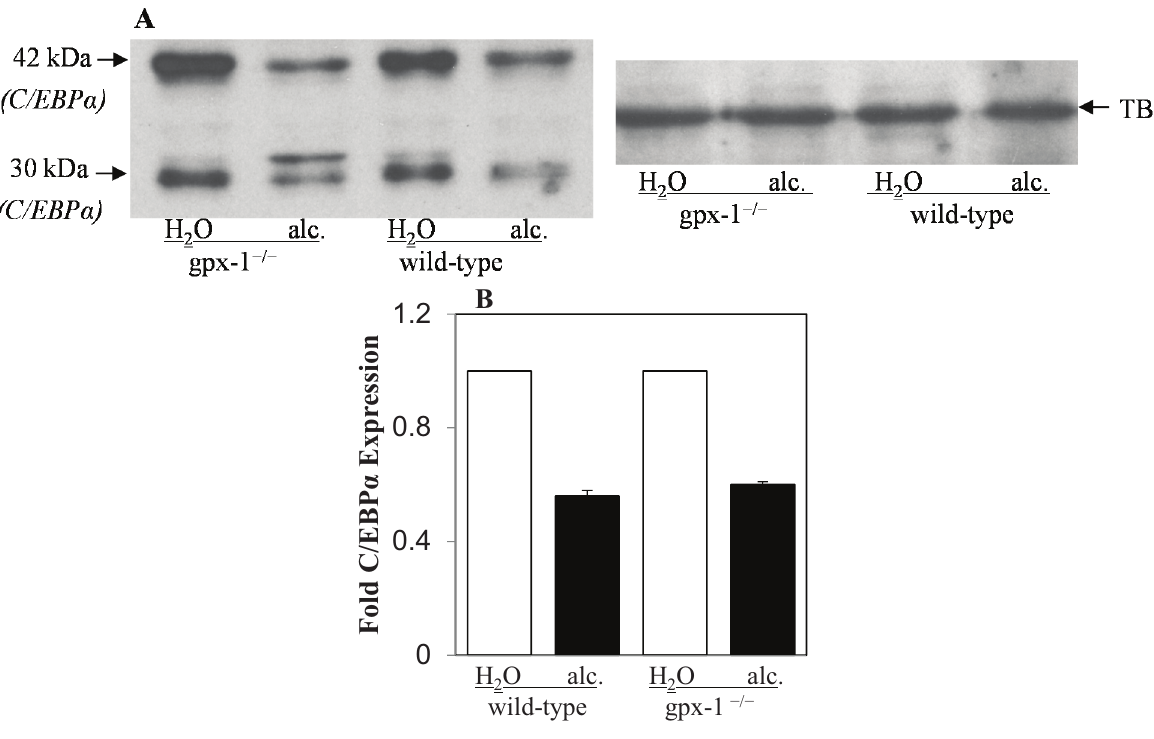
Figure 4. Liver C/EBP(cid:3) protein expression. ( A) Nuclear cell lysates isolated from the livers of H 2 O or ethanol (alc.)-fed wild-type and gpx-1 (cid:2)/(cid:2) transgenic mice were employed to detect C/EBP(cid:3) protein expression by western blotting. An anti-TATA-binding protein (TBP) antibody was used to demonstrate equal nuclear protein loading. ( B ) C/EBP(cid:3) protein (30 kDa and 42 kDa) expression was quantified by densitometric analysis and normalized to TBP expression. Normalized expression in H 2 O or alcohol-fed gpx-1 (cid:2)/(cid:2) and alcohol-fed wild-type mice was expressed as fold expression of that in H 2 O-fed wild-type